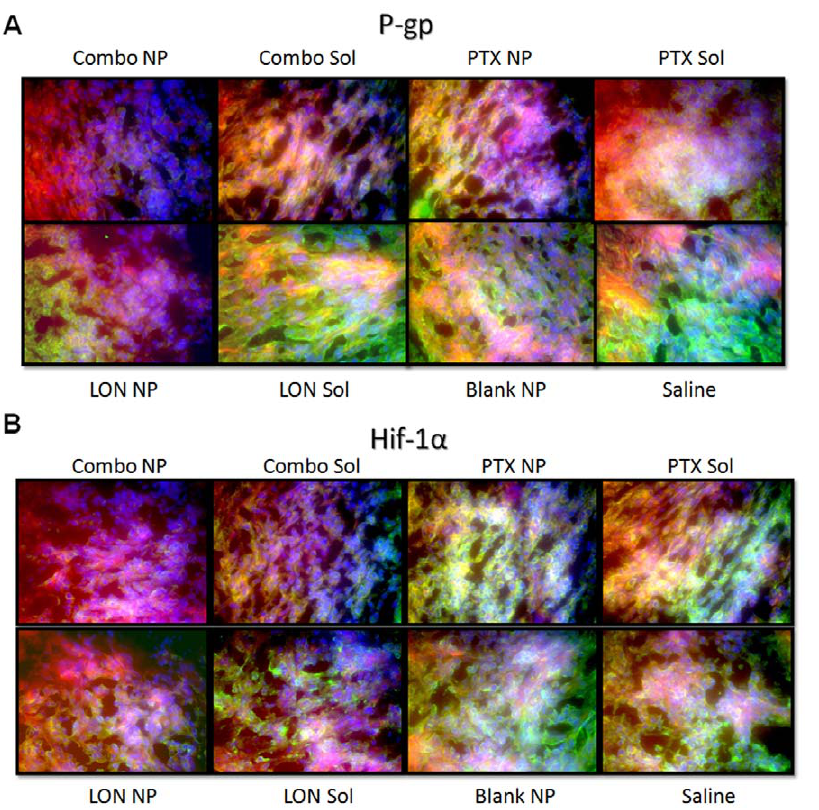
Figure 6. Immunohistochemistry of P-gp and HIF-1 a . Tissue sections were probed with primary antibodies against the protein of interest, then labeled with Alexa Fluor H 488 conjugated secondary antibodies (green). F-actin was stained with Alexa Fluor H 568 phalloidin (red) and nuclei were stained with Hoechst 33342 (blue).